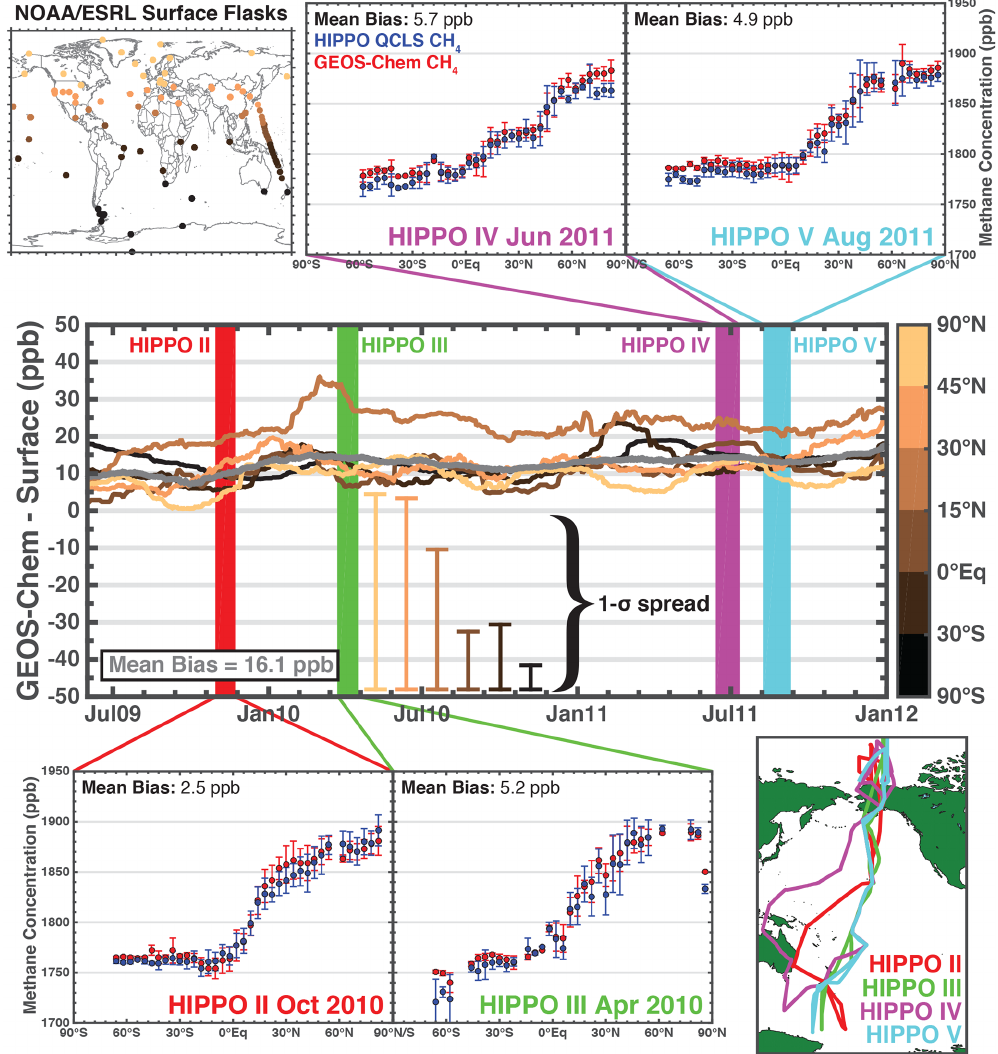
Figure A3. Global evaluation of the GEOS-Chem methane simulation at 4 ◦ × 5 ◦ resolution (using prior emissions) with observations from the NOAA/ESRL surface flask network (top left panel colored by latitude) and HIPPO aircraft deployments. The central panel shows 3- month running medians for 2009–2011 of the difference between GEOS-Chem and the flask data in different latitudinal bands. The gray line is for all of the observations. Error bars for the running medians are offset from the lines for clarity. Latitudinal profiles across the Pacific for the four HIPPO deployments over the period are also shown: in those panels the symbols represent the pressure-weighted tropospheric average concentrations and the vertical bars are the standard deviation. Stratospheric air is excluded based on an ozone–CO concentration ratio larger than 1.25 (Hudman et al., 2007). Bottom right panel shows the HIPPO flight